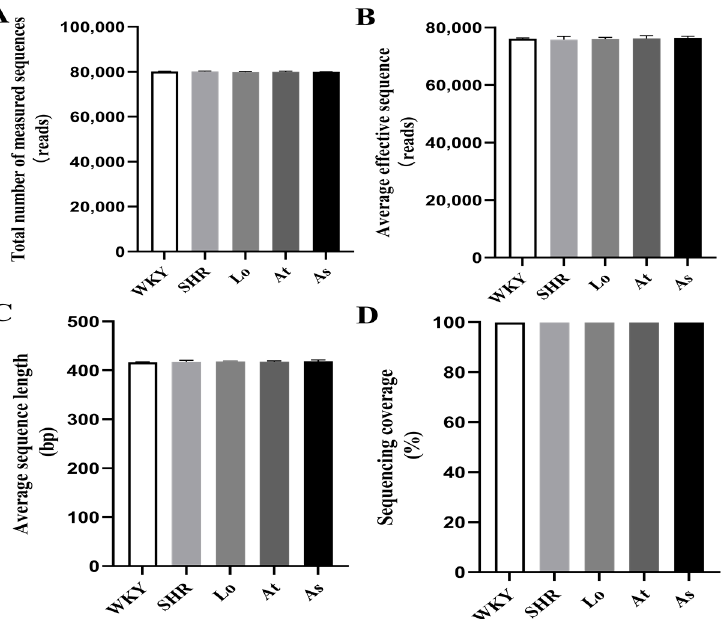
Figure 2. Quality control of sequencing data. ( A ) Total number of measured sequences. ( B ) Average effective sequence. ( C ) Average sequence length. ( D ) Sequencing coverage. The data are presented as the mean ± SD, n = 6.